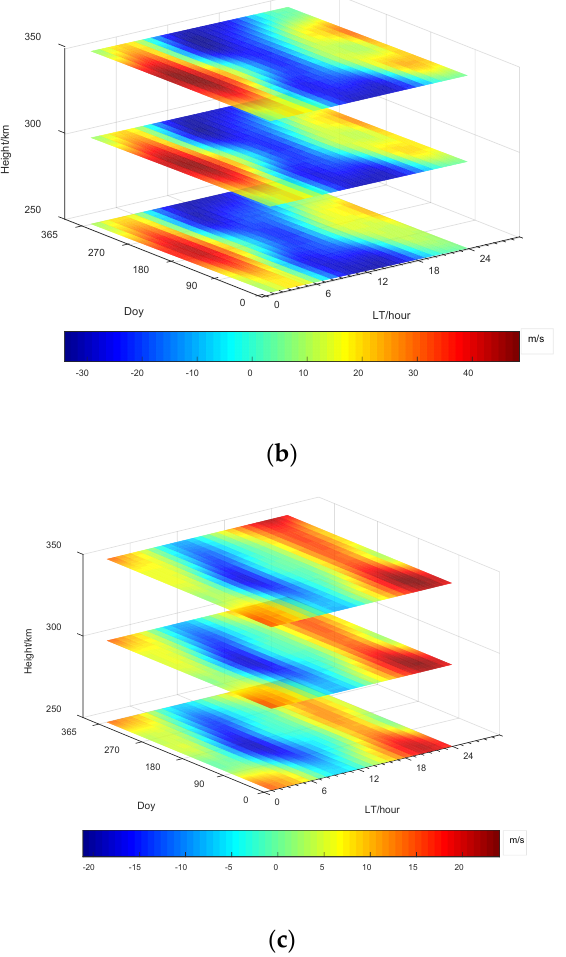
Figure A1. The difference in east (60°E, 47.5°N) and west (135°E, 47.5°N) vertical drift velocity at ( a ) 250 km, ( b ) 300 km and ( c ) 350 km heights calculated by the HWM-14 model and IGRF-2020 model. Table A1. Statistics of the difference in the east region (125 ◦ E–145 ◦ E, 45 ◦ N–50 ◦ N)-west region (50 ◦ E– 70 ◦ E, 45 ◦ N–50 ◦ N) uplifting electron flux obtained from the COSMIC Nm F2 data and vertical drift velocity calculated from the HWM-14 model. he red color represents the Nm F2 in winter, the blue color represents the Nm F2 in summer, the yellow color represents the Nm F2 in equinox.